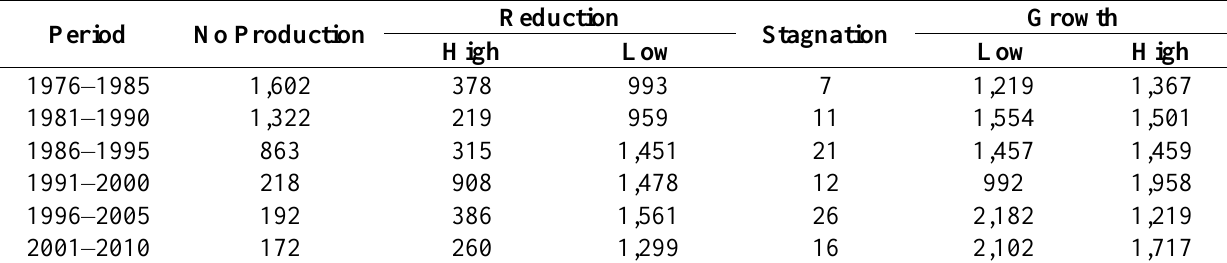
Table 1. Number of Brazilian municipalities—sheep production